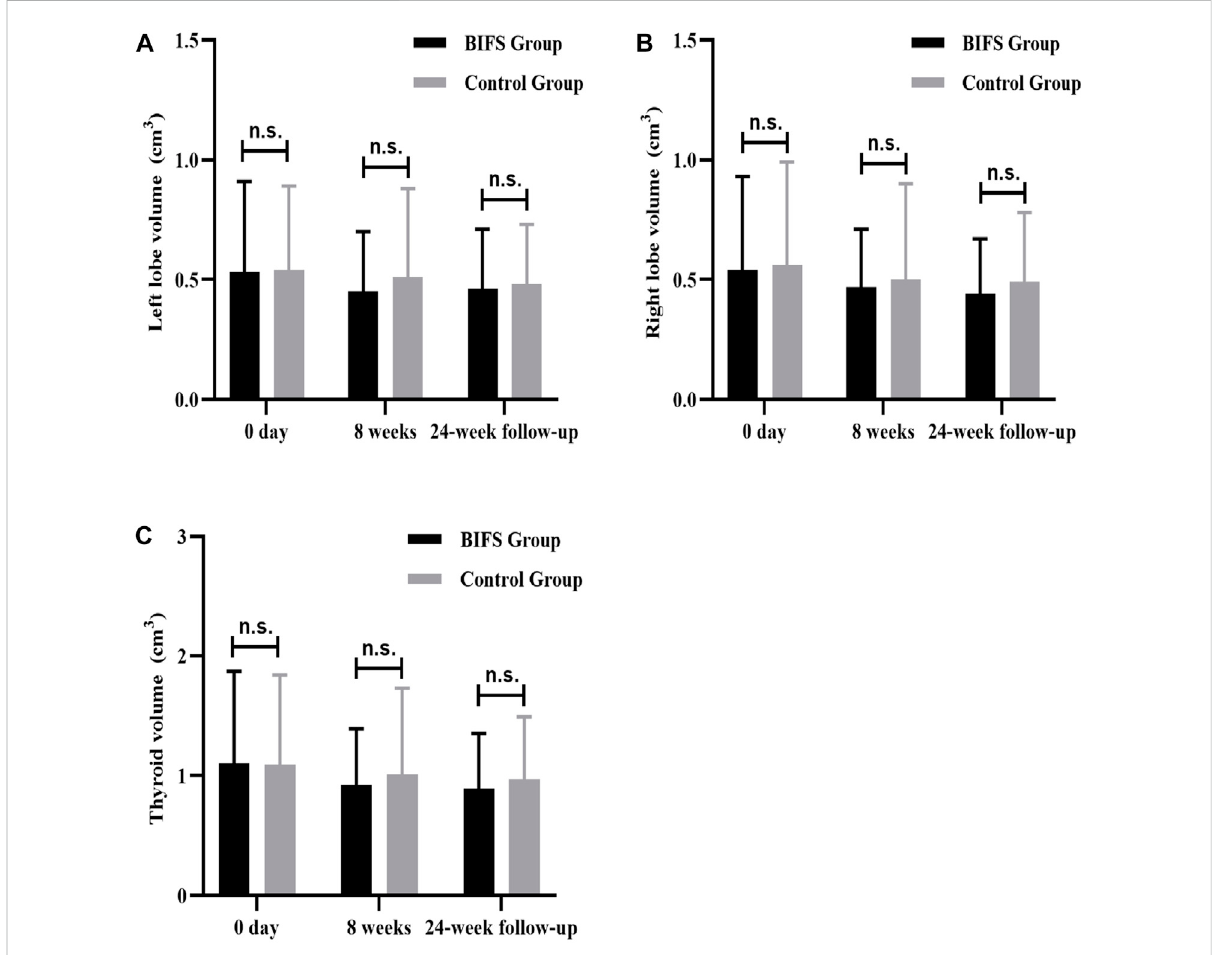
FIGURE 6 Thyroid volume differences at baseline, after eight treatment weeks, and at 24-week follow-up. (A) Thyroid volume of left lobe; (B) Thyroid volume of right lobe; (C) Total thyroid volume; n.s., no statistically signi fi cant